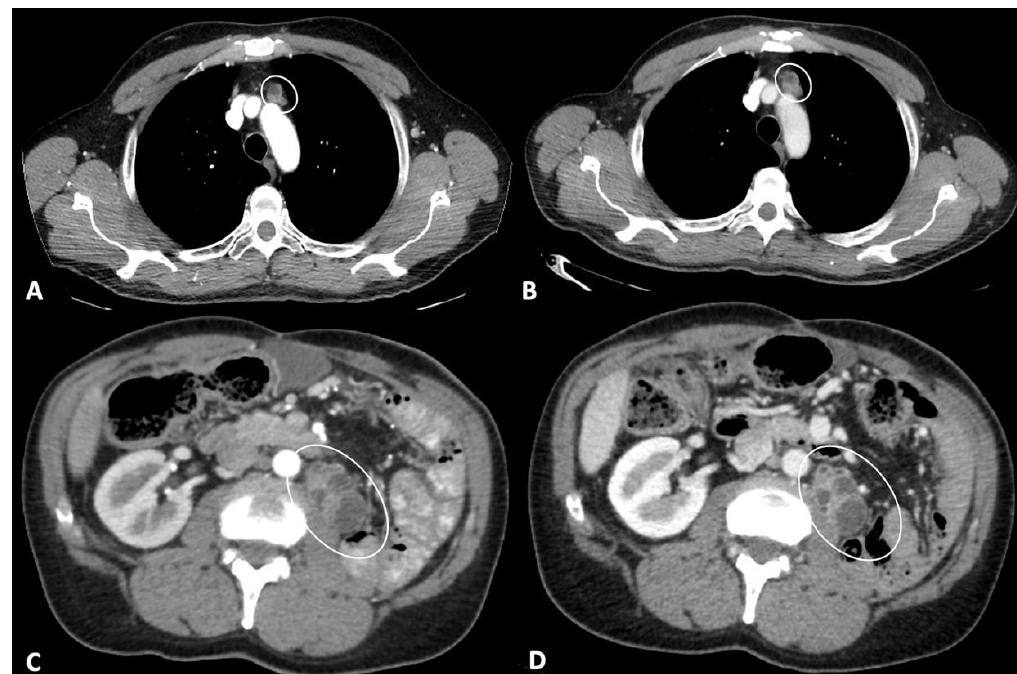
Figure 1. CT axial scans in a male patient, 59 years old, with chest and abdominal lymph node metastases before ( A , C ) and after ( B , D ) medical treatment. The patient underwent left nephrectomy for the primary tumor (clear cell RCC) and was medically treated with cabozantinib (60 mg/die) when disease recurrence occurred during the post-surgical follow-up. CT images show chest ( A , B ) and abdominal para-aortic ( C , D ) partially necrotic lymphoadenopathies which remained stable at re-evaluation as stable disease according to mCHOI criteria (Table 1).